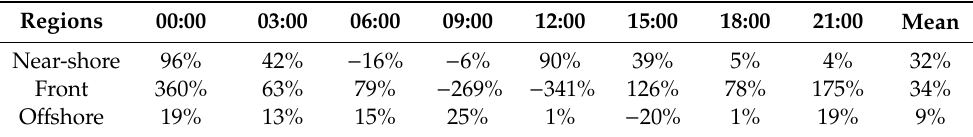
Table 5. The contribution of CO 2 flux variation caused by biological processes to F CO2 (Cont) in the mixed layer.